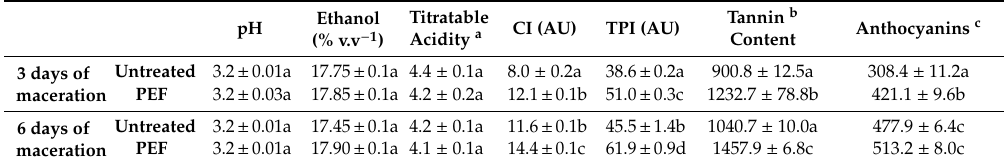
Table 1. Physico-chemical characteristics of wines obtained with 3 and 6 days of skin maceration from untreated and PEF-treated grapes at the time of bottling and aging in oak